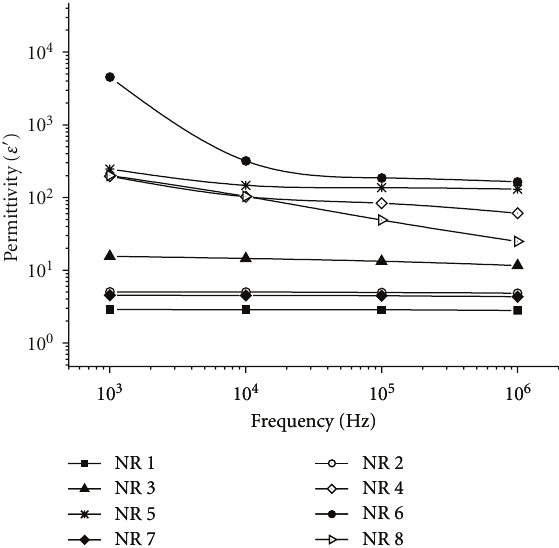
Figure 2: Temperature dependence of the mechanical loss angle tangent (tan δ ) for composites comprising di ff erent amounts of Printex XE-2B or Corax N220.